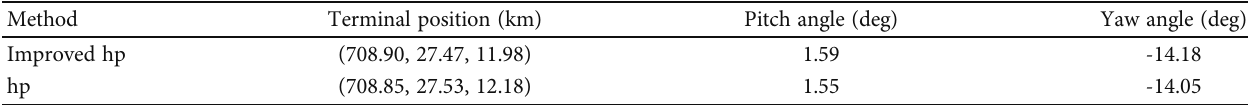
Table 3: Terminal state of missile in the midcourse fl